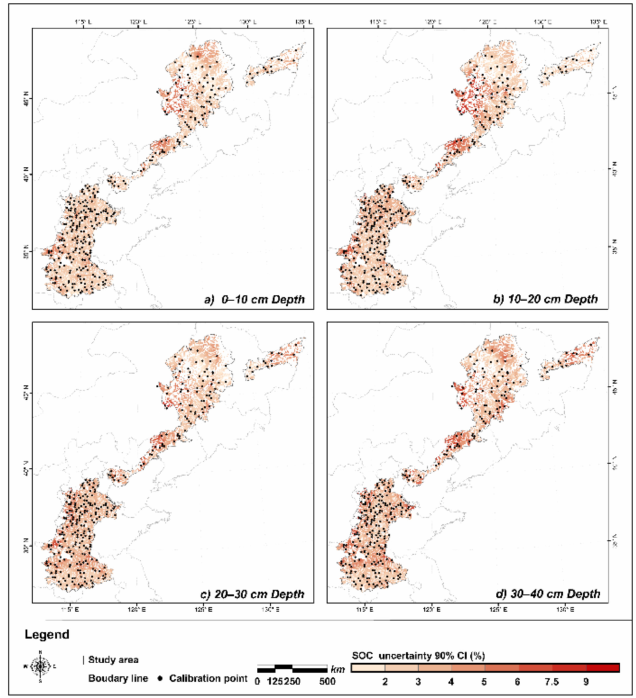
Figure 8. Spatial and vertical distribution pattern of uncertainty with RF in ( a ) 0–10 cm depth, ( b ) 10–20 cm depth, ( c ) 20–30 cm depth and ( d ) 30–40 cm